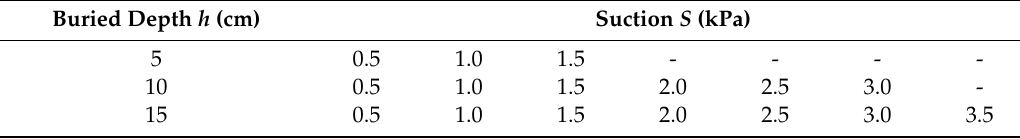
Table 2. List of visual tests on suction caissons.